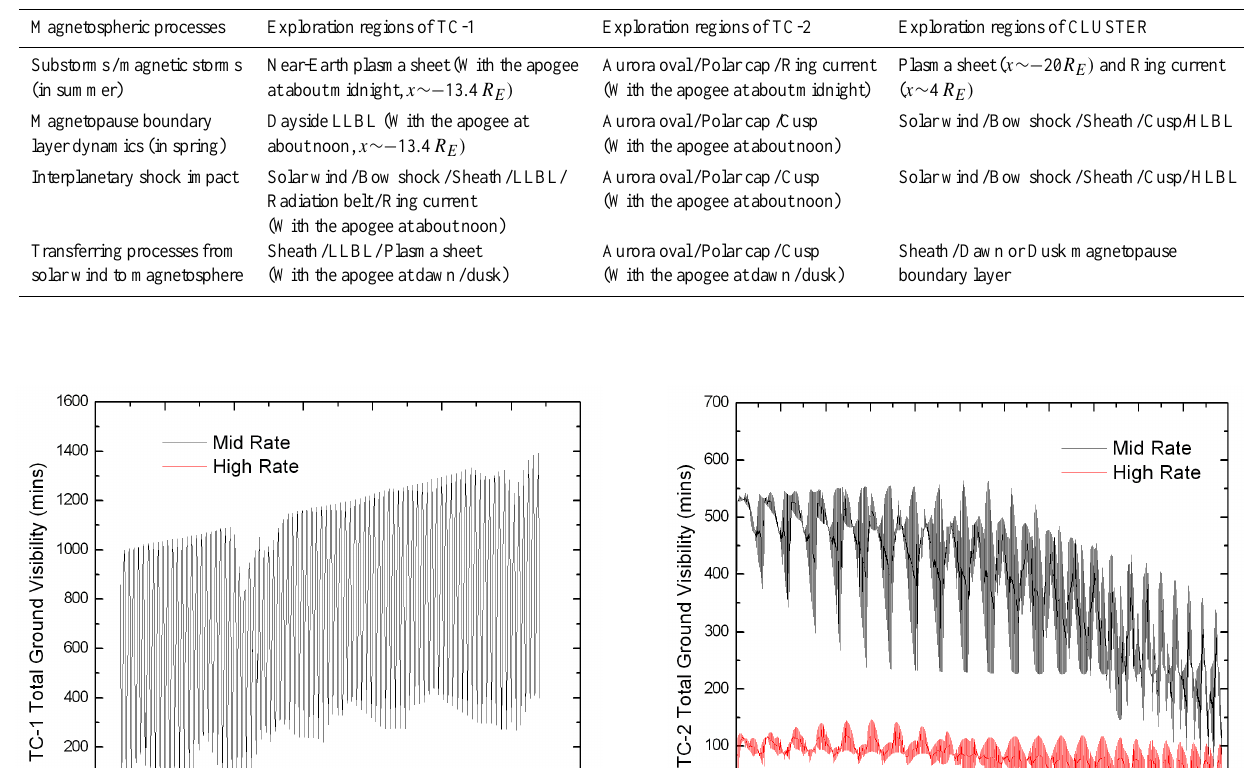
Table 2. The coordinated observations of TC-1, TC-2 and Cluster.